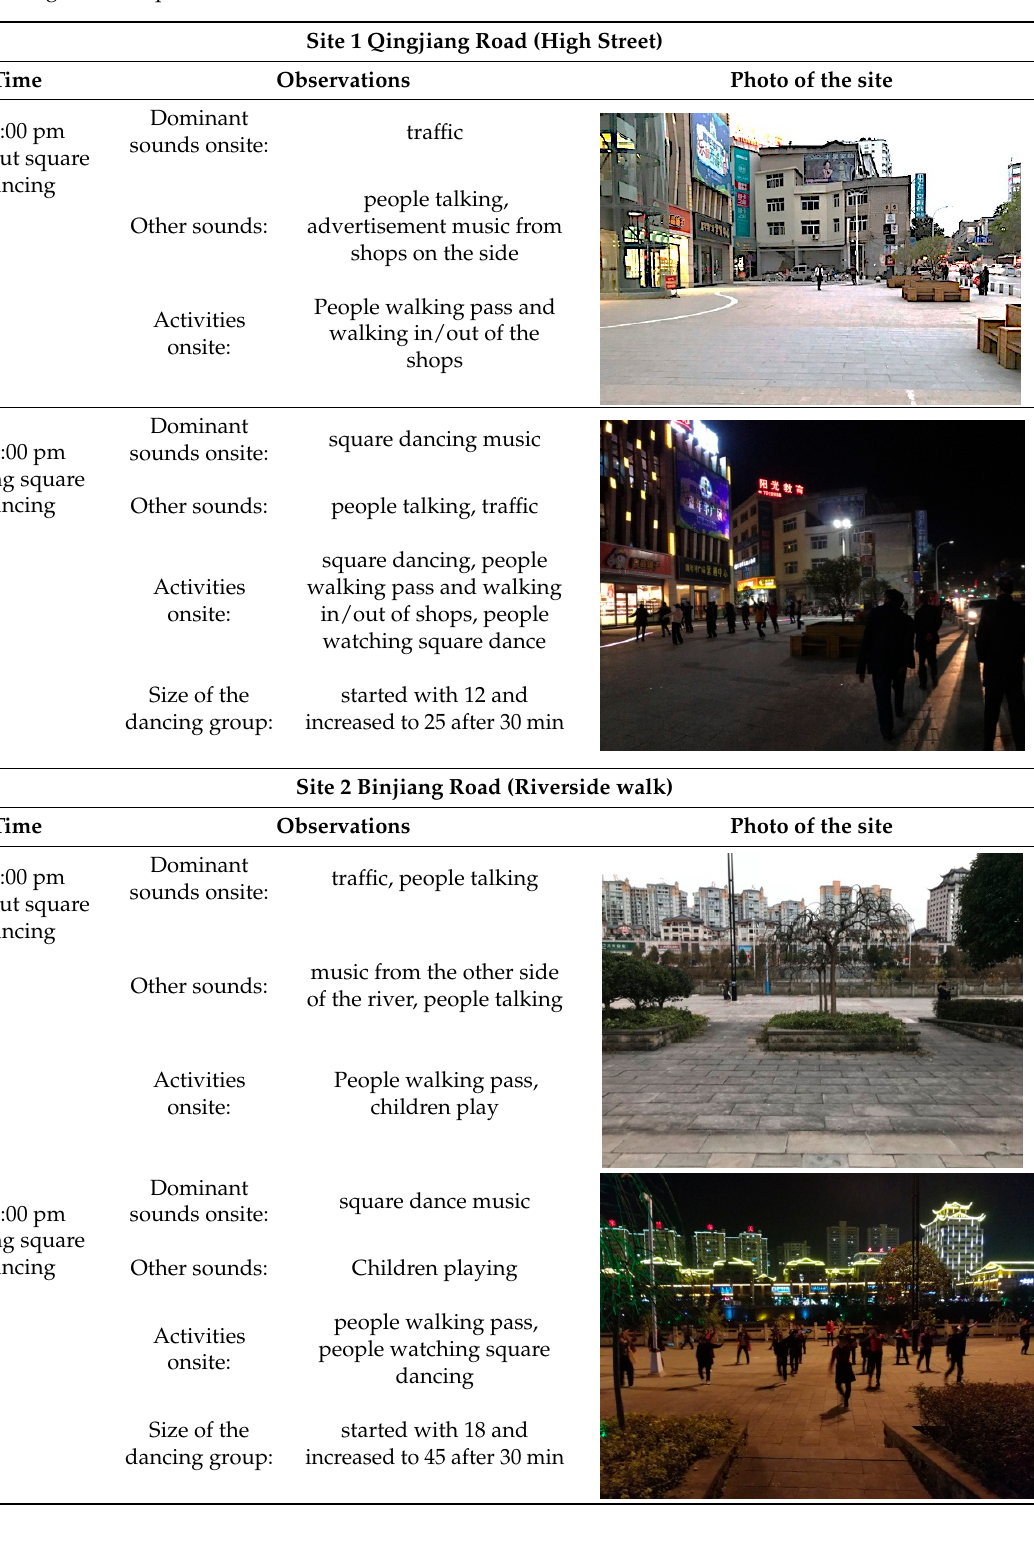
( b ) Figure 2. Illustrations of points for measurements onsite during the dance (where the red dot represents the location of the speaker and light grey dots represent participants in the square dancing): ( a ) layout of measuring settings in relation to the speaker at site 1; ( b ) layout of measuring settings in relation to the speaker at site 2. Rather than noise monitoring, repeated recordings in short intervals are useful to capture the characteristics of the acoustic environment in an urban context [26]. In order to compare with no dancing conditions, a set of three 1-minute recordings were performed in position a and c as taken in in-session measurements to obtain an A-weighted equivalent sound level. The measurements outside the session were conducted between 1:00 and 2:00 p.m. to get a representative acoustic environment in streets for normal everyday city life. Considering the fluctuating sound features of square dancing music, the peak levels (L Amax ) will also be recorded to reflect on attractions of attentions during the dance.